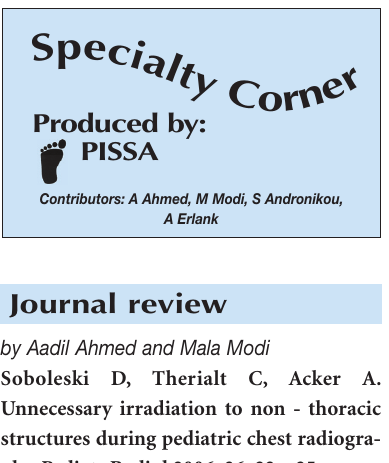
Figs 1 and 2. Images demonstrating the course of the duodenum, consistent with duo- denum